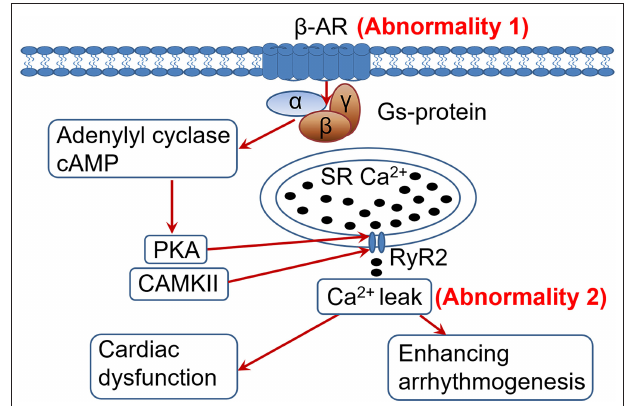
FIGURE 1 | Heightened adrenergic signaling in the presence of cardiac ryanodine receptor (RyR2) dysfunction and Ca 2 + leak is detrimental. In heart failure (HF), sustained adrenergic activation leads to hyperphosphorylation (among other posttranslational modifications) of the RyR2 by PKA and CaMKII (through PKA-independent signaling mediated by β 1-AR activation), resulting in RyR2 dysfunction and pathological Ca 2 + leak. Desensitization /down-regulation of the β -AR (abnormality 1) would diminish adrenergic signaling, alleviating RyR2 dysfunction and Ca 2 + leak (abnormality 2) than they would otherwise. In contrast, enhancing adrenergic signaling in HF would worsen the RyR2 dysfunction and Ca 2 + leak (abnormality 2), exacerbating cardiac dysfunction and arrhythmogenesis. PKA, protein kinase A; CaMKII, Ca 2 + /calmodulin-dependent protein kinase II; SR, sarcoplasmic reticulum; RyR2, cardiac ryanodine